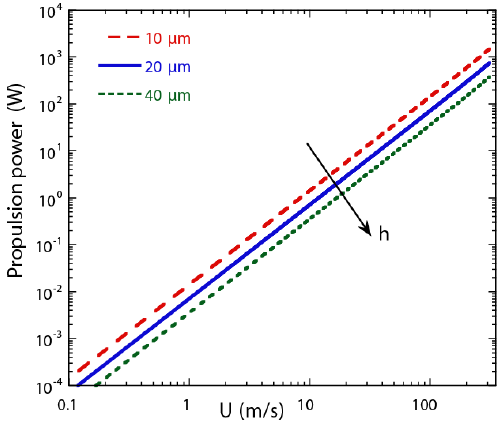
Figure 4. Propulsive power requirement of air bearing at di ff erent Hyperloop speeds U for di ff erent gap height h . Power scaling ( ∼ U 2 / h ) evident in all